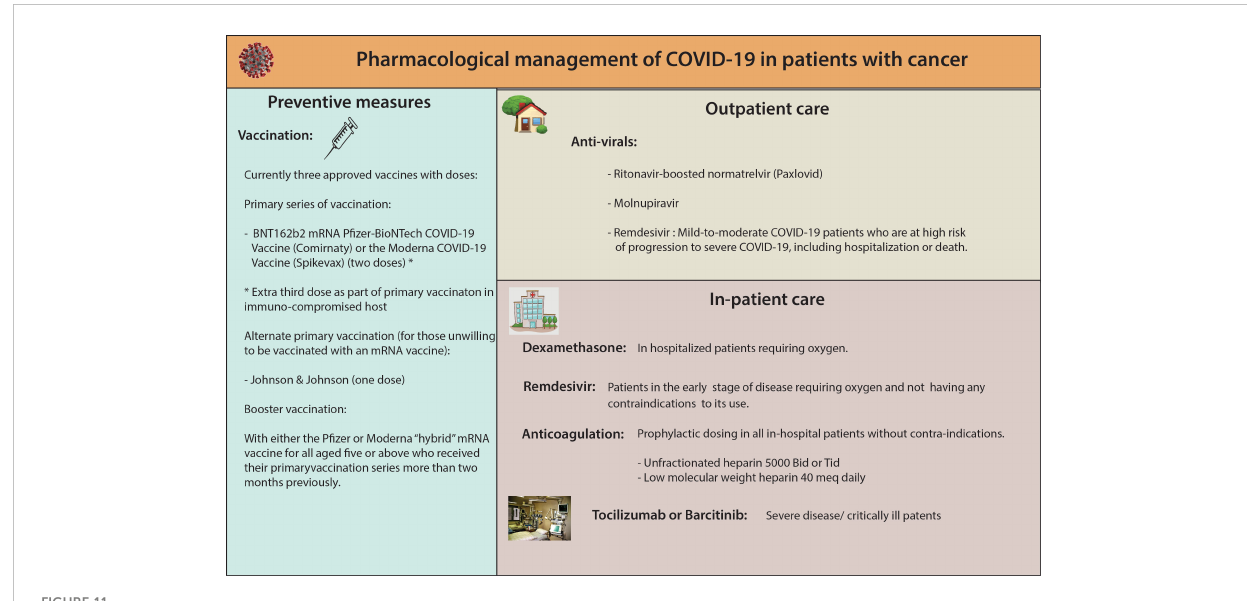
FIGURE 11 Pharmacological management of COVID-19 in patients with